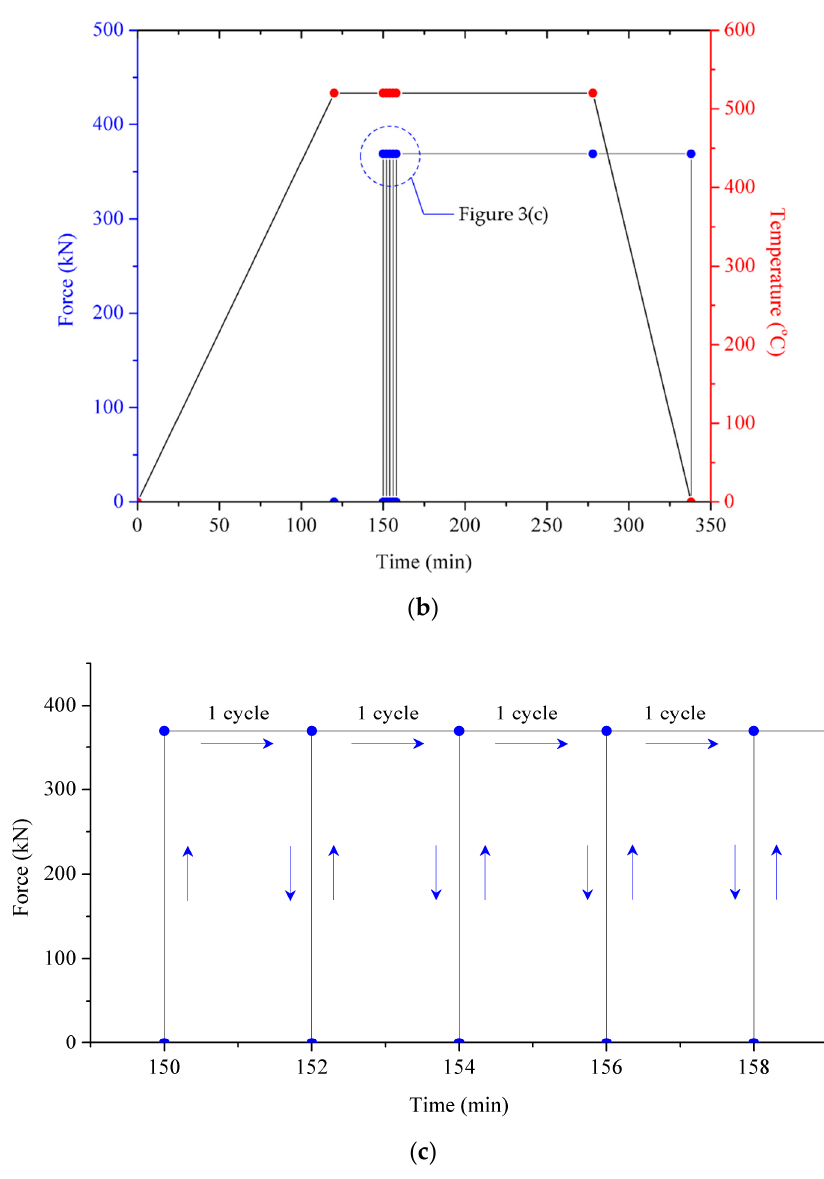
Figure 3. Hot press forging ( a ) overall process, ( b ) force-temperature parameter, and ( c ) time interval during the forging phase [23].